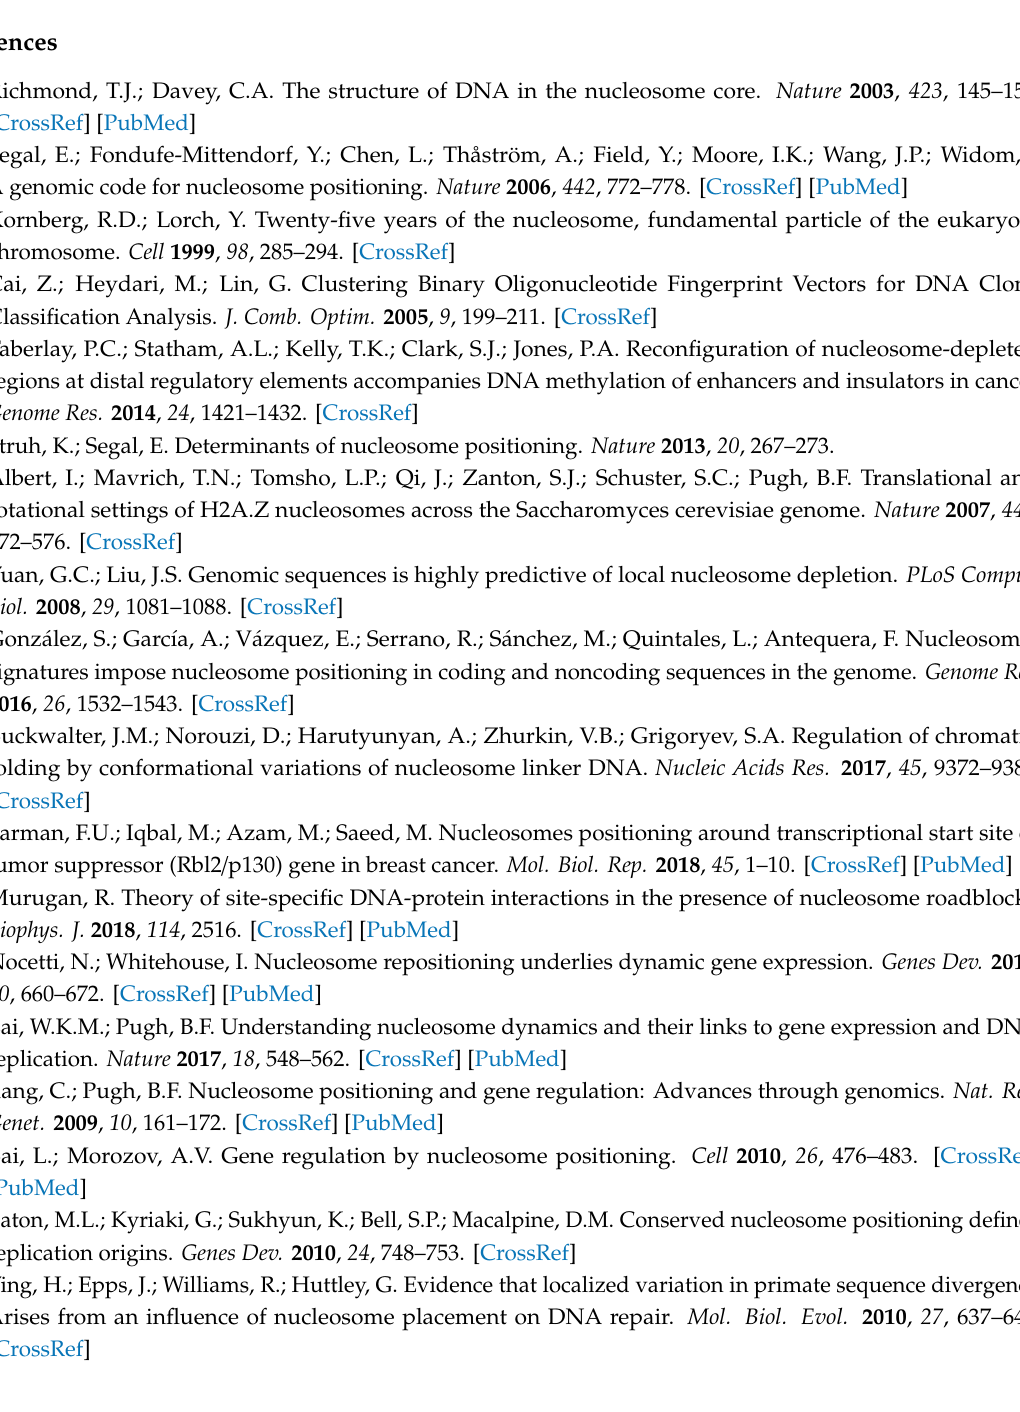
Figure S1: Statistical test of our models of nucleosomal and linker sequences by visualization for S. cerevisiae (Wilcoxon rank-sum test), Figure S2: Statistical test between a random nucleosomal and a random linker sequence by visualization for S. cerevisiae (Wilcoxon rank-sum